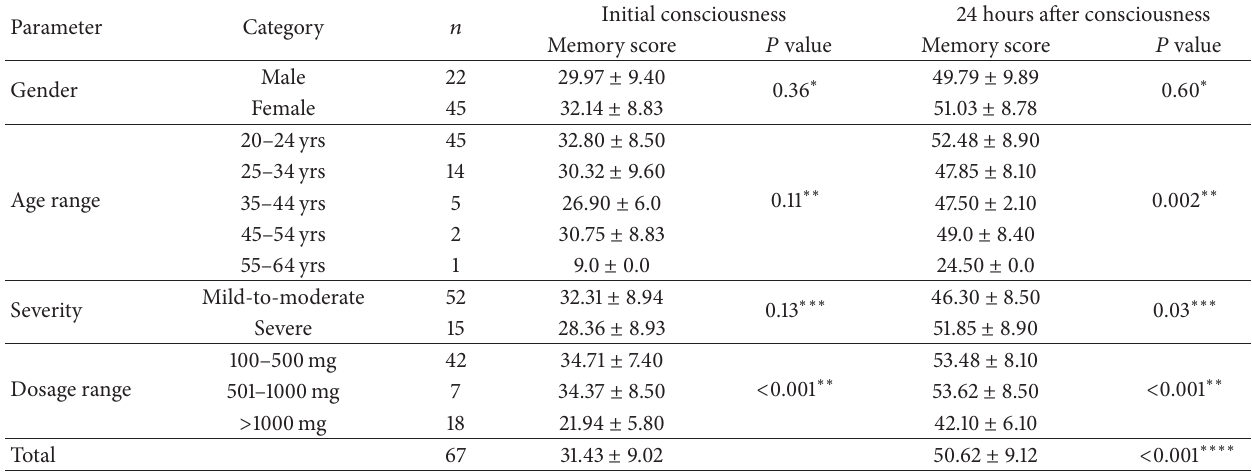
Table 1: Memory score of TCA-poisoned patients in terms of different parameters at the time of initial consciousness † and 24 hours afterward (mean ± SD) ( 𝑛 = 67